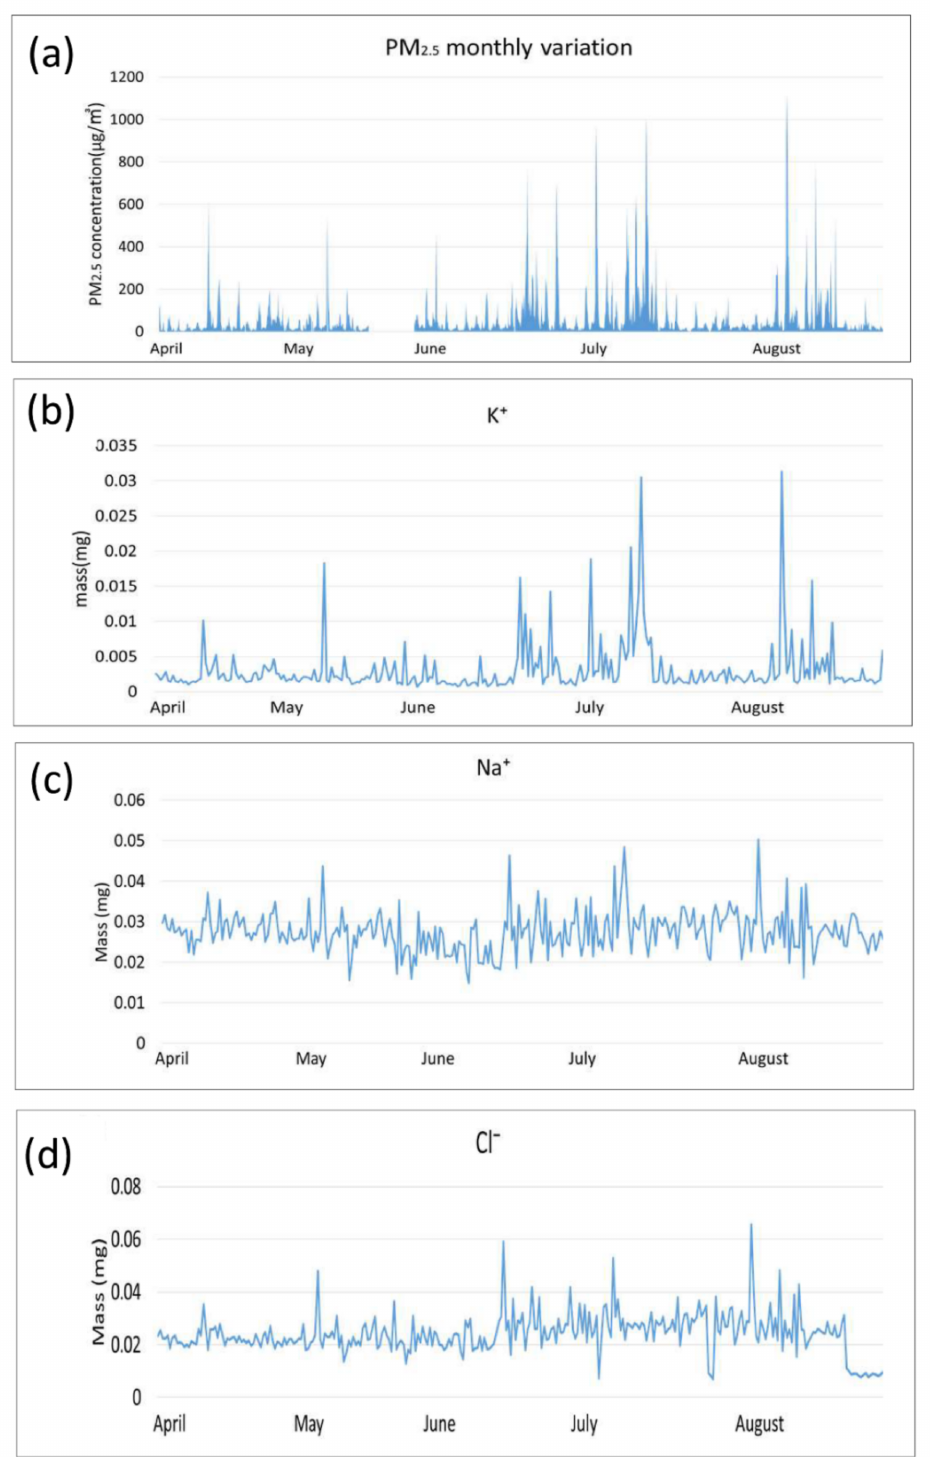
Figure 8. April 2019 to August 2019 (part of autumn–winter) monthly variation in ( a ) PM 2.5 concen- tration, ( b ) K + concentration, ( c ) Na + concentration, and ( d ) Cl −